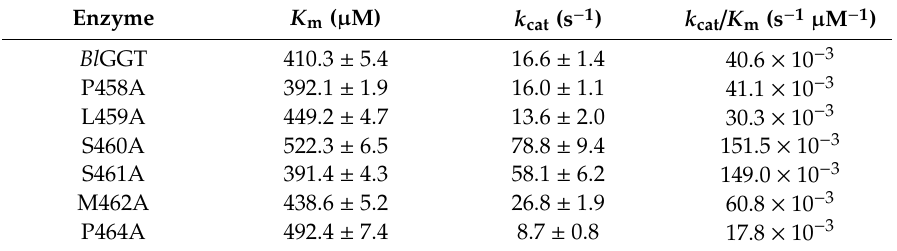
Table 2. Kinetic parameters of the freshly prepared wild-type and Ala-replacement enzymes.